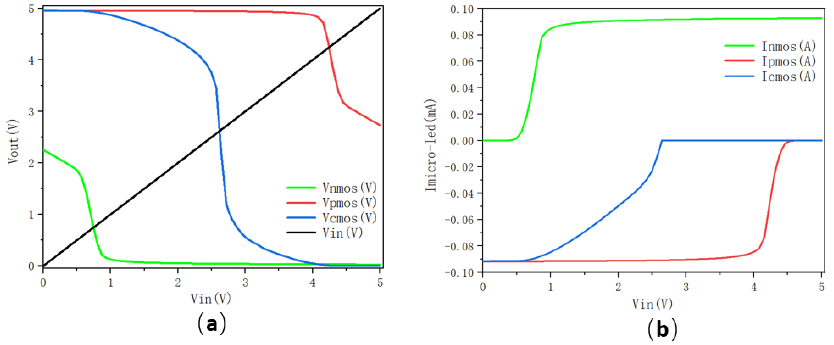
Figure 11. ( a ) output voltage-input voltage graph. ( b ) Output current-input voltage graph.